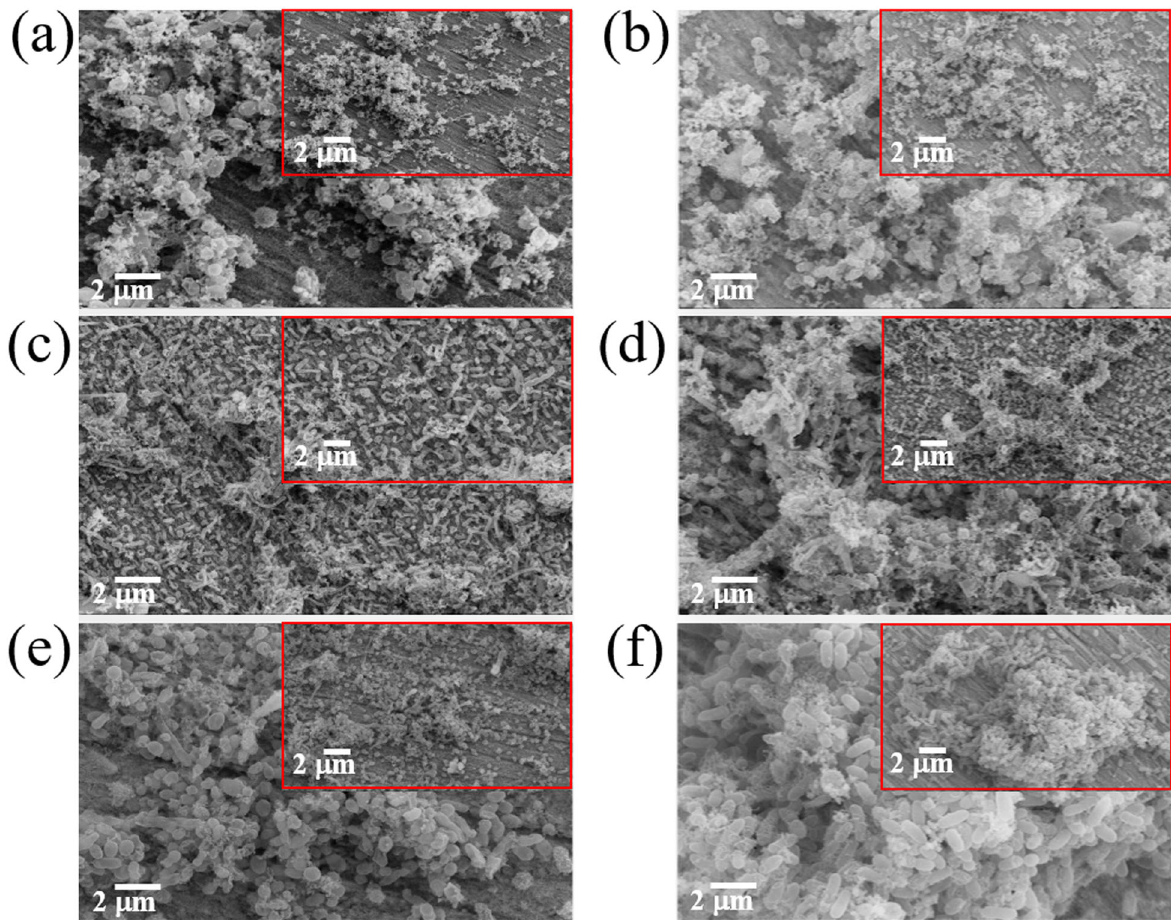
Fig. 1 FESEM images of bio fi lms on X80 coupons. a , b Bio fi lms of V . parahaemolyticus after 7 d and 14 d. c , d Bio fi lms of V . alginolyticus after 7 d and 14 d. e , f Bio fi lms of Vibrio sp. EF187016 after 7 d and 14